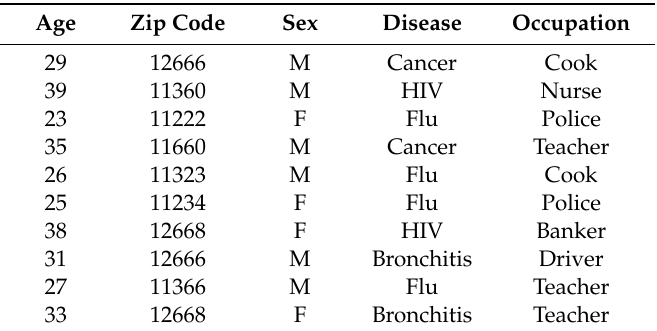
Table 9. Result of attribute partition.